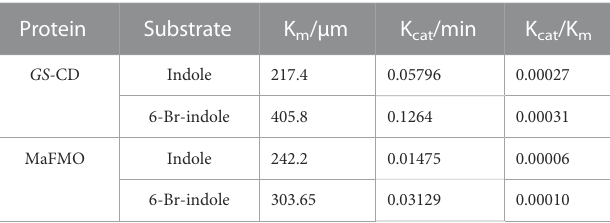
TABLE 5 Steady-state kinetic parameters for NADH oxidation activity on various substrates by GS -CD and MaFMO. Protein